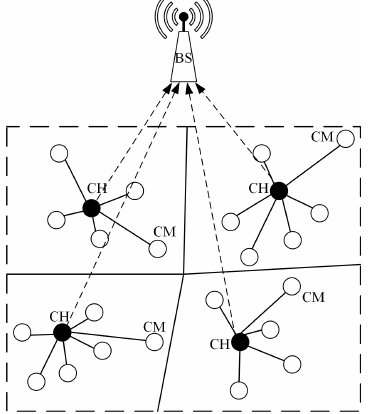
Figure 2. Schematic diagram of the network